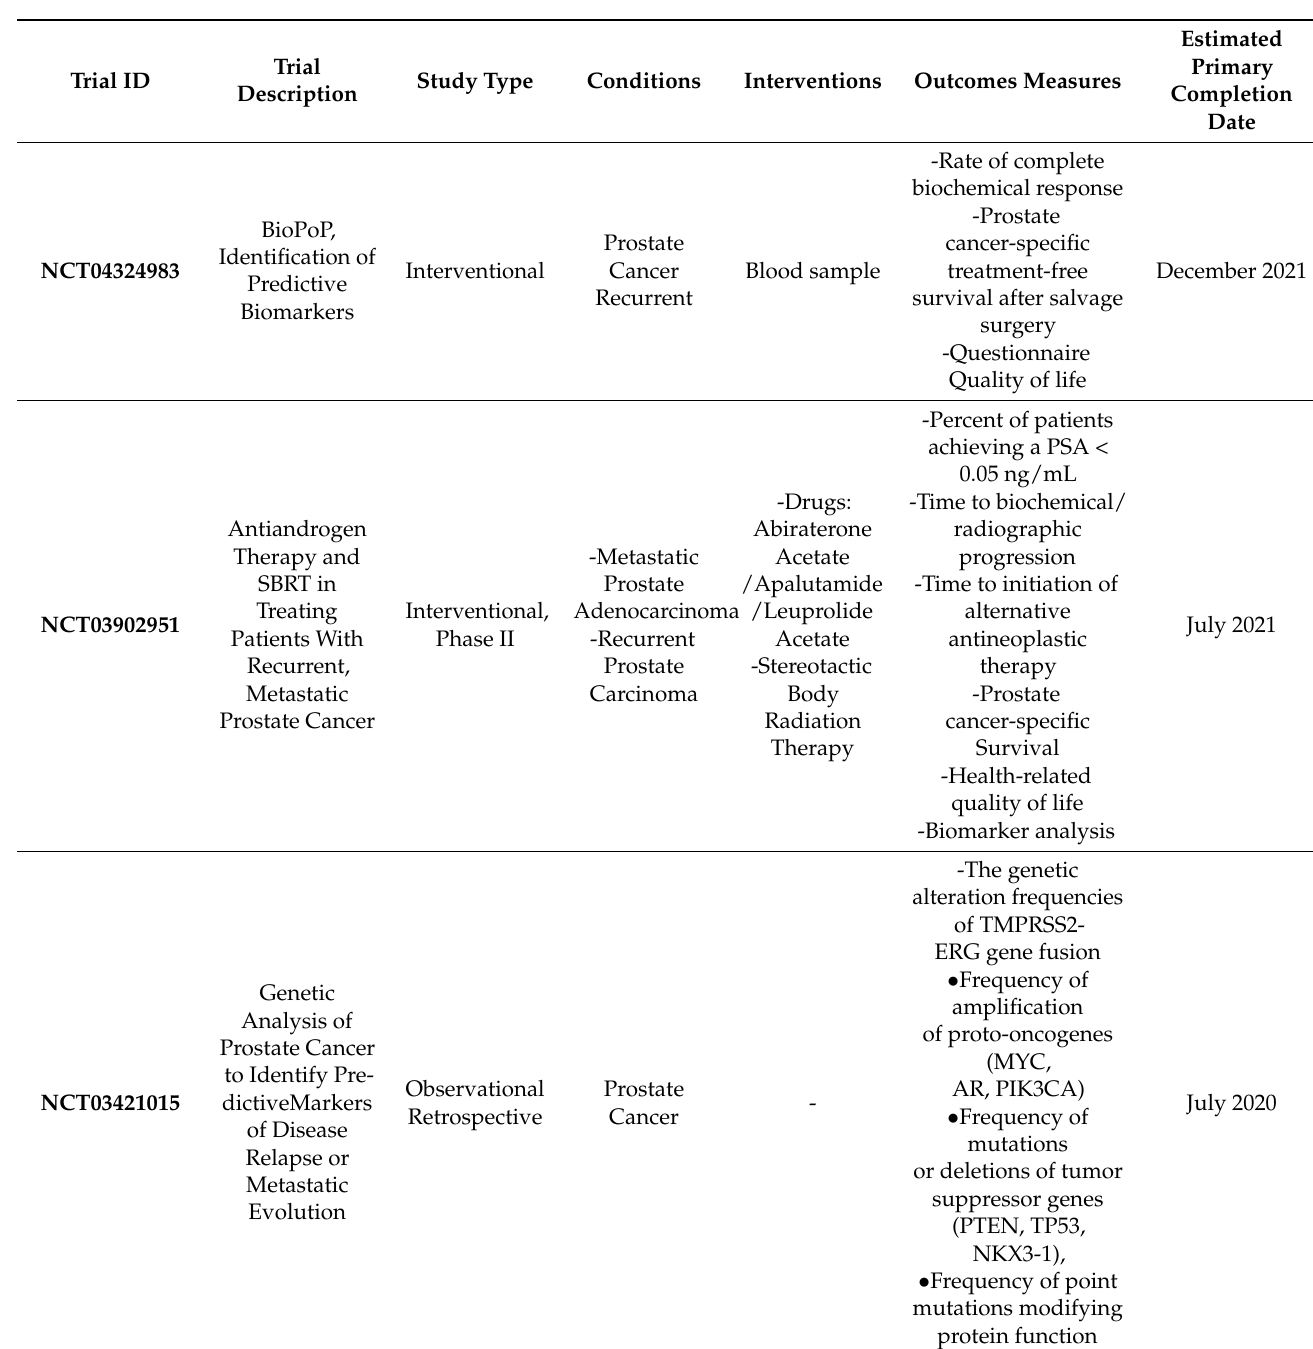
Table 2. Summary of ongoing trials (all in the recruiting phase) for the identification of predictive biomarkers for prostate